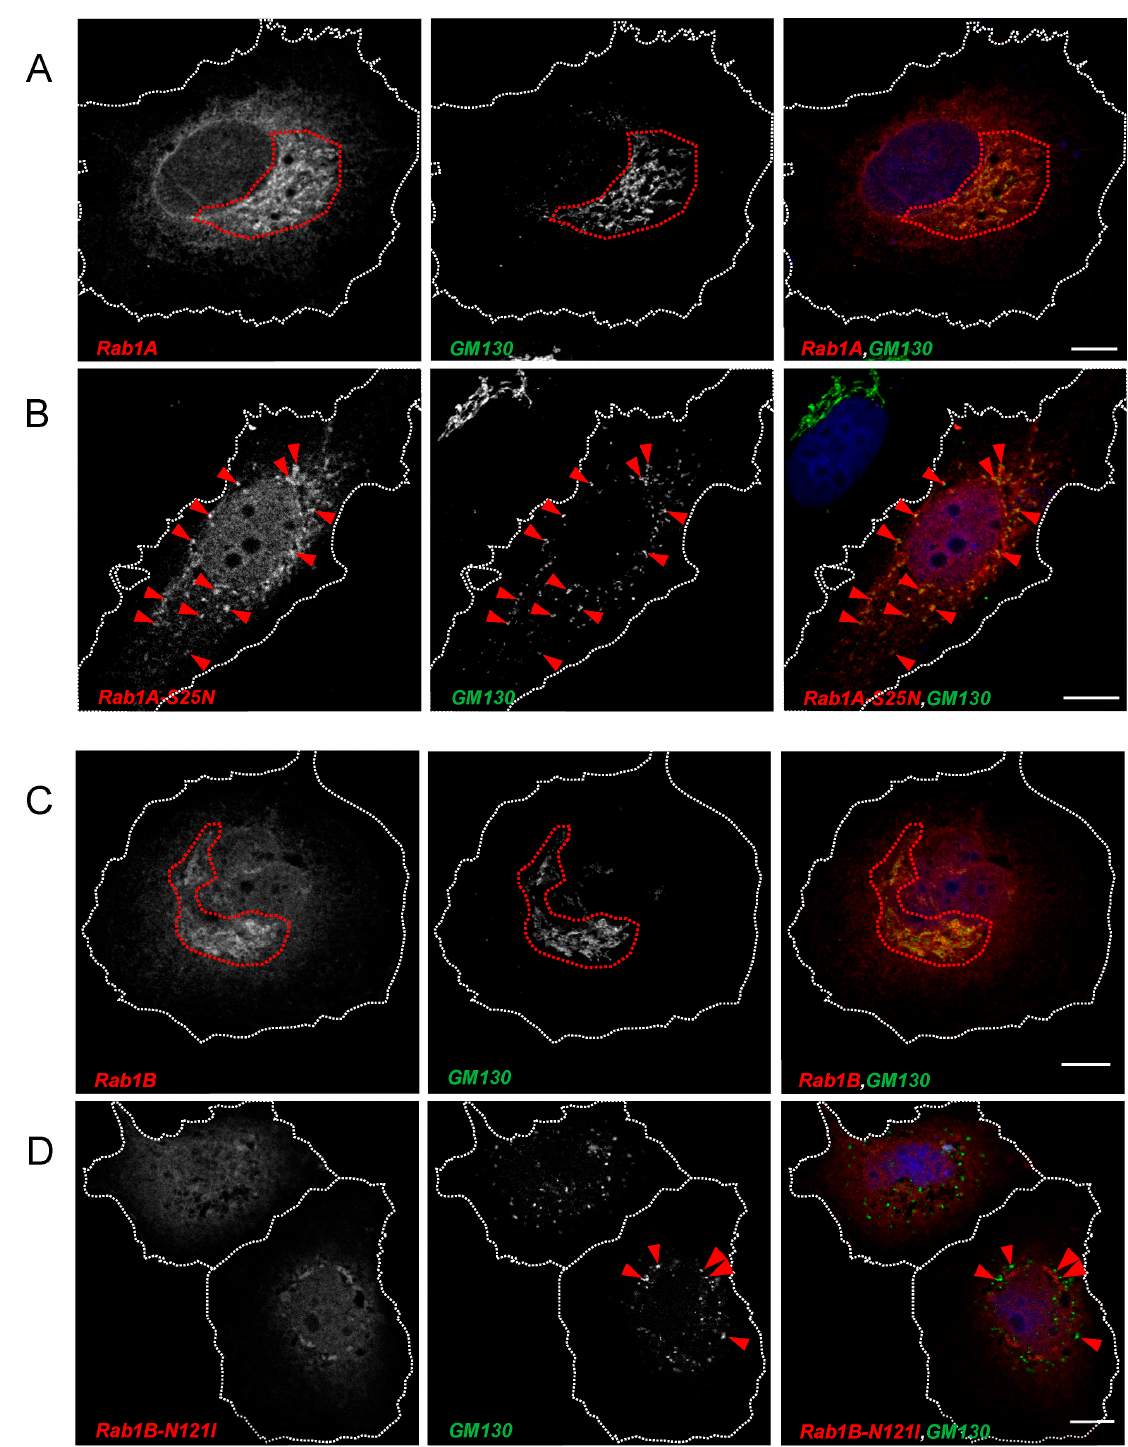
Figure 6. Effect of ectopic expression of Rab1A, Rab1B or the corresponding DN mutants on the distribution of endogenous GM130. Subconfluent HuH7 cells were transfected with ( A ) pCMV-Rab1A-myc, ( B ) pCMV-Rab1A-S25N-myc, ( C ) pCMV-Rab1B-myc or ( D ) pCMV-Rab1B-N121I-myc respectively. Cells were fixed 24 hpt and stained for endogenous GM130 (green), Rab1A/Rab1B (anti-myc, red) and nuclei (blue) with DAPI. Scale bars indicate 10 µm. Encircled area marks a coherent organization of the Golgi systemand arrows demonstrate a scattered Golgi system. GM130 single staining can be found in Figure S4B. Data are representative of two independent experiments.